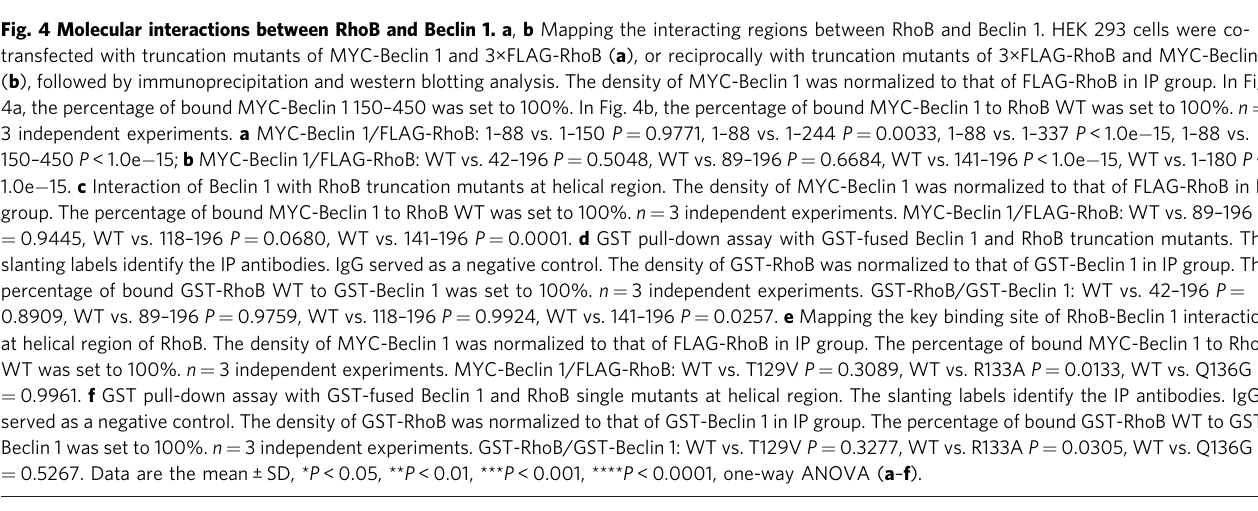
Fig. 4 Molecular interactions between RhoB and Beclin 1. a , b Mapping the interacting regions between RhoB and Beclin 1. HEK 293 cells were co- transfected with truncation mutants of MYC-Beclin 1 and 3×FLAG-RhoB ( a ), or reciprocally with truncation mutants of 3×FLAG-RhoB and MYC-Beclin 1 ( b ), followed by immunoprecipitation and western blotting analysis. The density of MYC-Beclin 1 was normalized to that of FLAG-RhoB in IP group. In